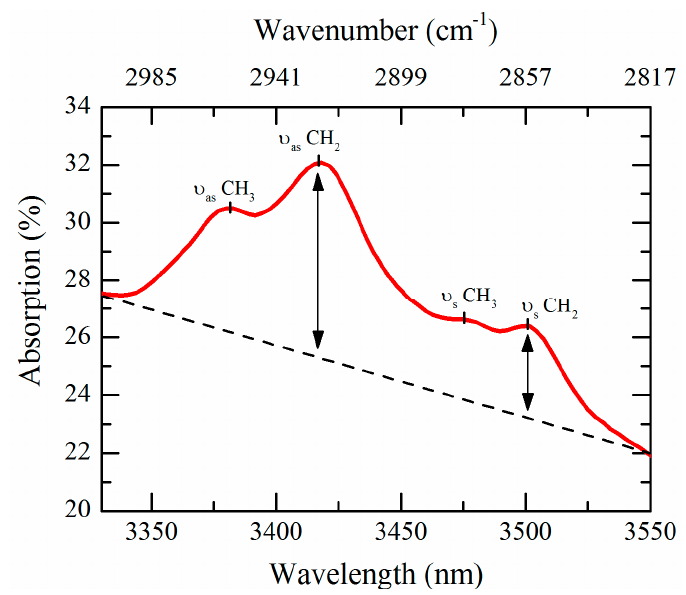
Figure 1. Typical infrared absorption spectrum of healthy skin tissue in the 3330–3570 nm wavelength range (2800–3003 cm − 1 ) acquired using a Bruker Hyperion 3000 IR microscope coupled to a Tensor 37 spectrometer. The spectrum was recorded at 4 cm − 1 resolution for a total of four scans. Methyl (CH 3 ) and methylene (CH 2 ) symmetric ( ν s ) and asymmetric ( ν as ) stretching modes are indicated. The CH 2 stretch ratio is computed from the ratio between the CH 2 symmetric peak at 3505 nm and the CH 2 asymmetric peak at 3420 nm after straight baseline subtraction.